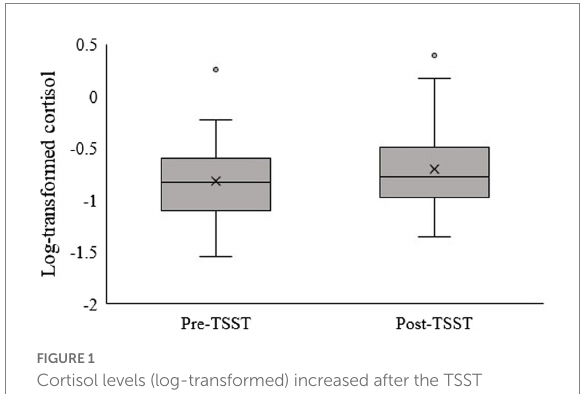
FIGURE 1 Cortisol levels (log-transformed) increased after the TSST ( t = − 3.230, p = 0.002, d = 0.48). three narcissism categories [ F